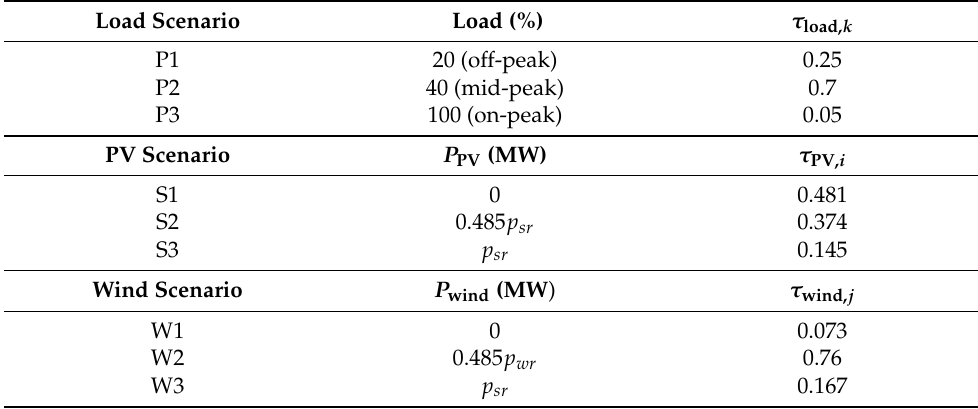
Table 1. Load, PV and wind scenarios and corresponding